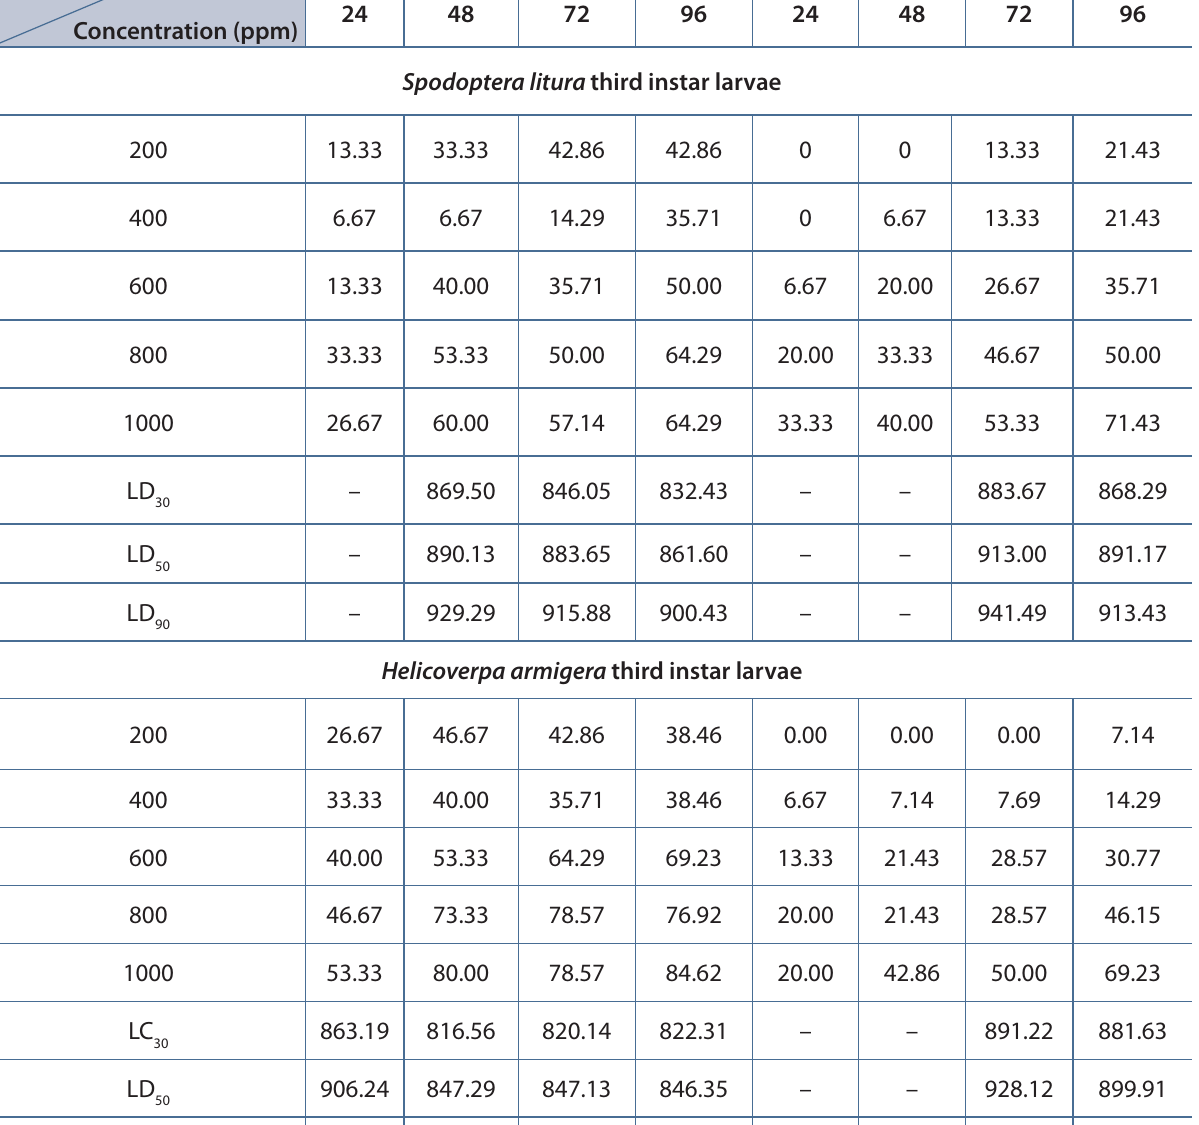
Table 1. Microinjection and oral administration of venomous saliva of R. fuscipes on the corrected mortality (%) at different exposure moments (24, 48, 72 and 96 hours), LC Spodoptera litura and Helicoverpa armigera third instar larvae LD values Concentration